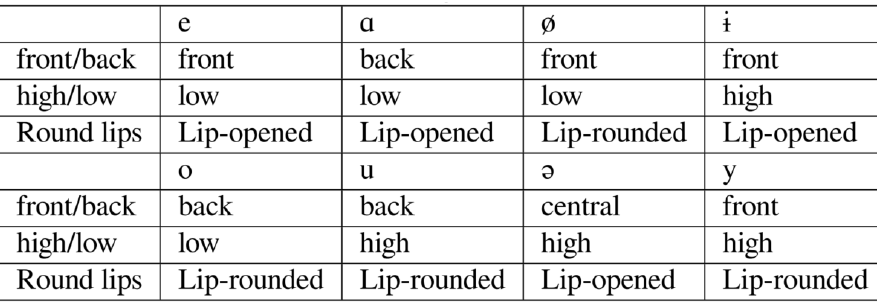
Figure A5. Kyrgyz